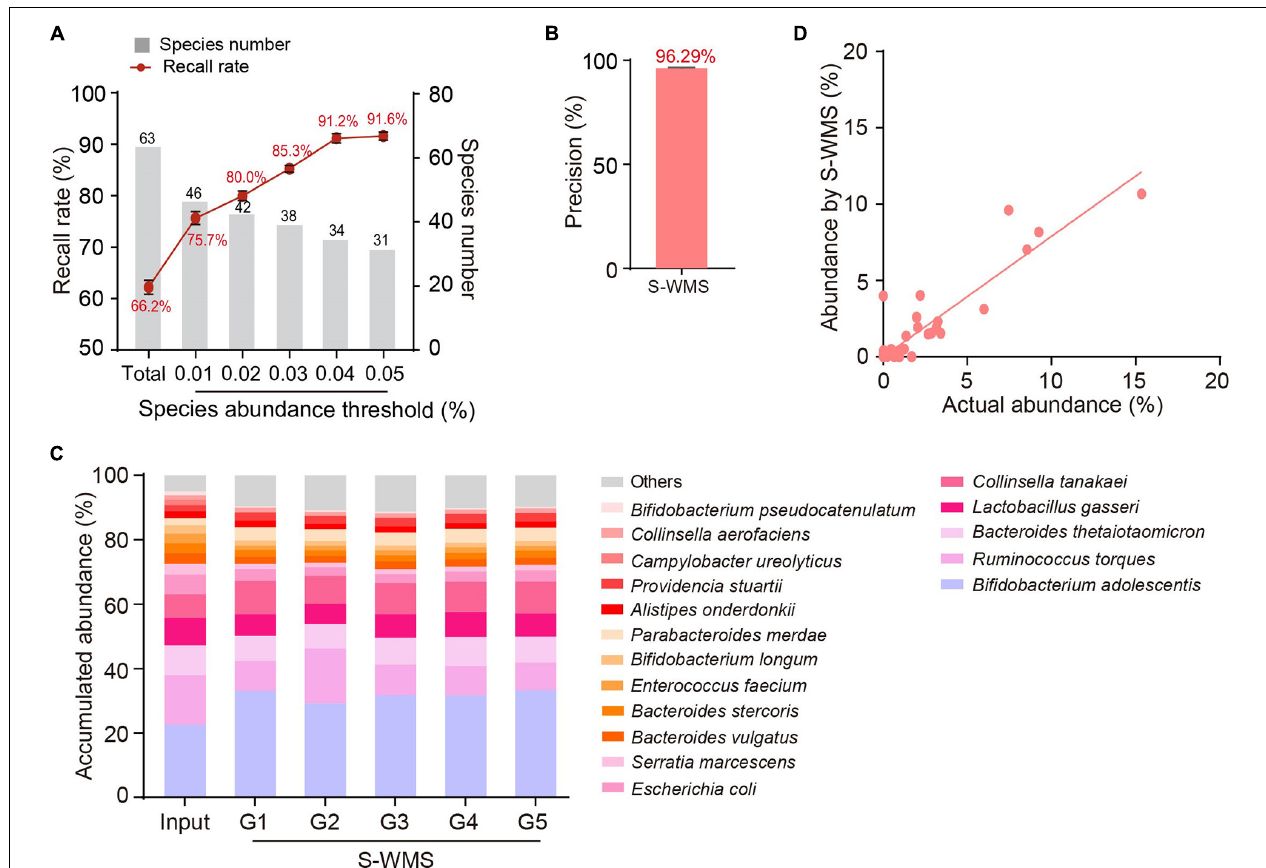
FIGURE 5 | Species assignment of a high complexity artificial microbial community (MOCK2) using S-WMS. (A) The recall rate of species types. The values on top of gray bars indicate the species numbers above each relative abundance threshold. The percentages on top of the curve nodes indicate the recall rate at each species abundance threshold. (B) Data precision of S-WMS. The mean value is marked on top of the bar graph. (C) Stacked bar plot of species abundances determined by S-WMS versus actual (Input) values. (D) Scatterplot of relative abundances of species determined by S-WMS versus expected (Input)